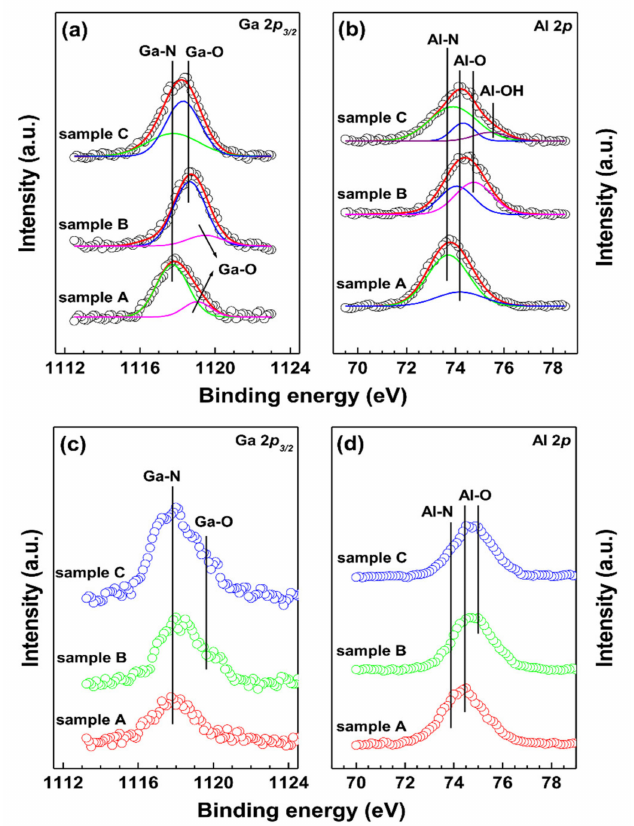
Figure 10. X-ray photoelectron spectroscopy (XPS) core level spectra of ( a ) Ga 3 p / 3 / 2 and ( b ) Al 2 p from the AlGaN surface, and ( c ) Ga 3 p / 3 / 2 and ( d ) Al 2 p from the AlGaN layer where the etch depth is 5